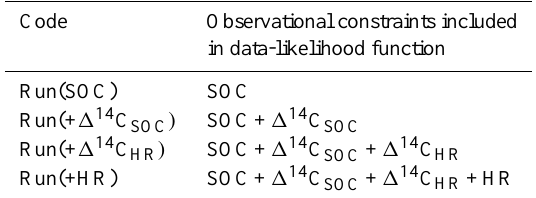
Table 2. Order of multiple constraints calibration